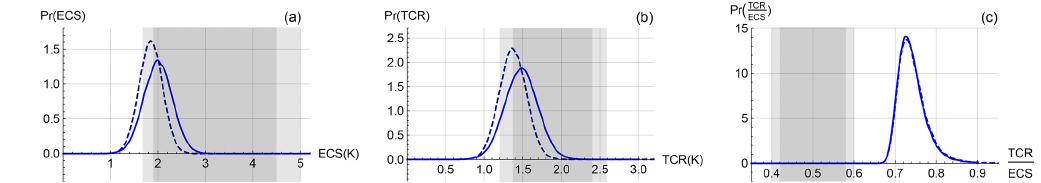
(dashed). The (solid) and F Aer SSP RCP